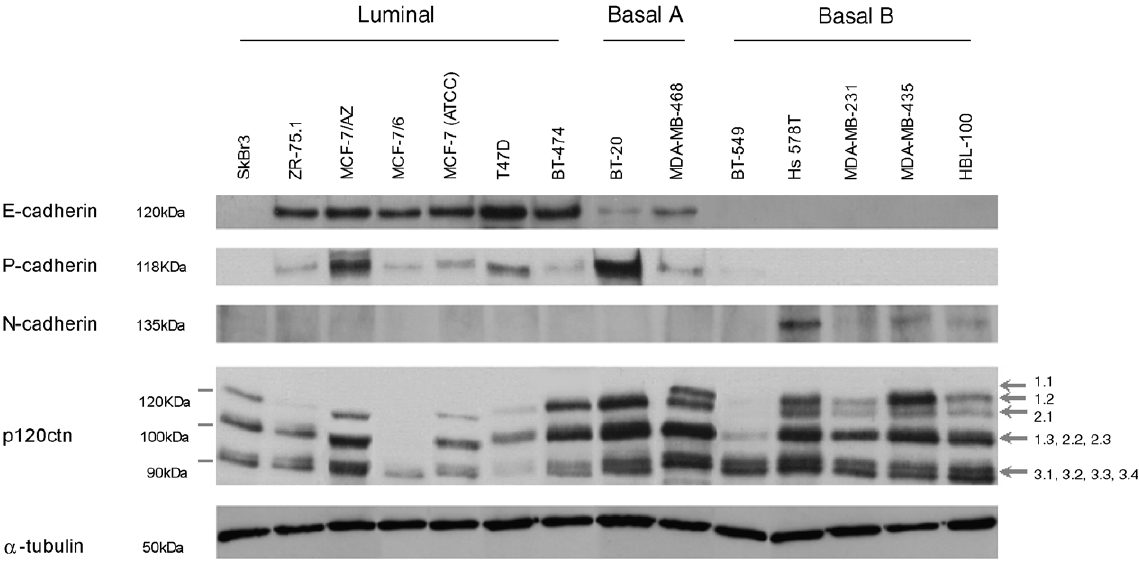
Fig. 5. Differential E-, P- and N-cadherin and p120ctn protein expression among breast cancer cell lines, analysed by Western blotting. Molecular weights are indicated on the left, while numeric p120ctn isoform codes are represented on the right. Immunostaining for anti- α -tubulin was done to control for equal